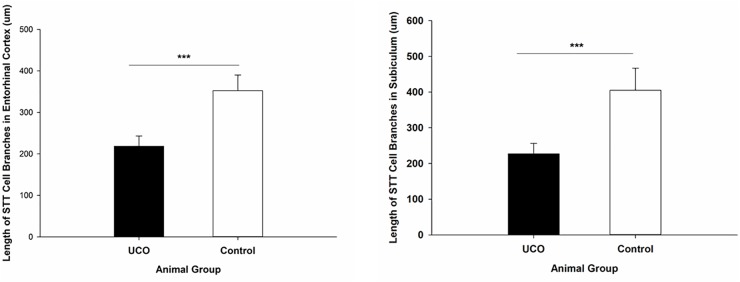
Morphological analysis of STT interneurons showed a significant effect of UCO on the length of the STT dendrites in subiculum and EC. Mean ± SD. ∗∗∗p < 0.001.